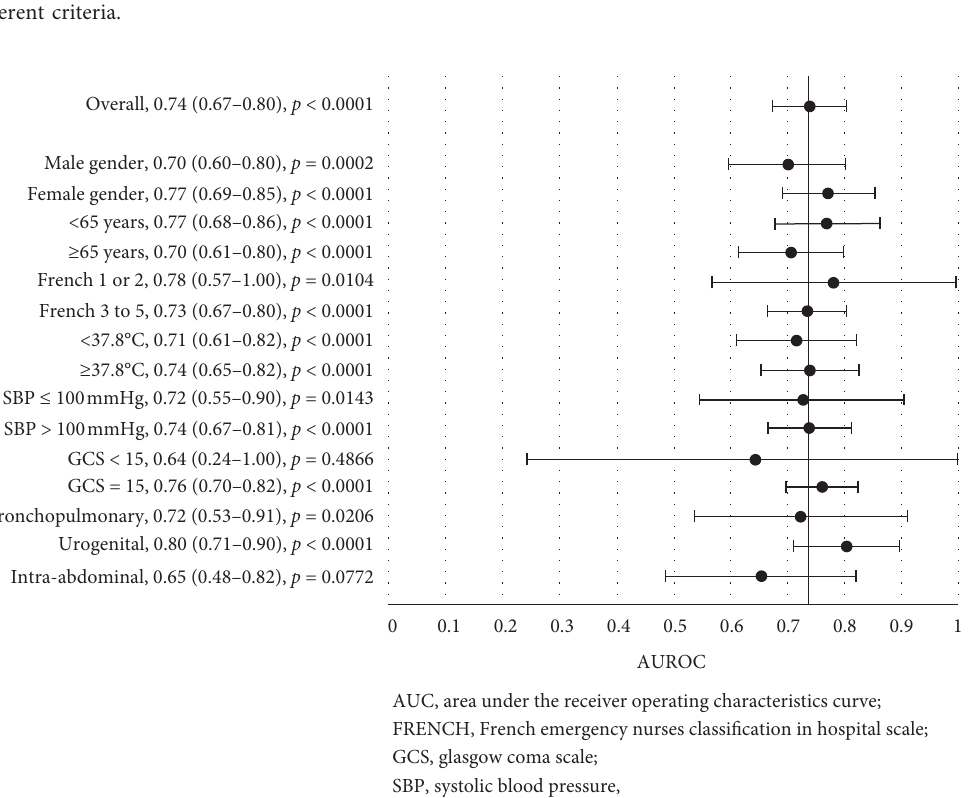
Figure 2: Forest plot of the area under the receiver operating characteristics curve for procalcitonin discrimination in ICU admission, stratified by different criteria.